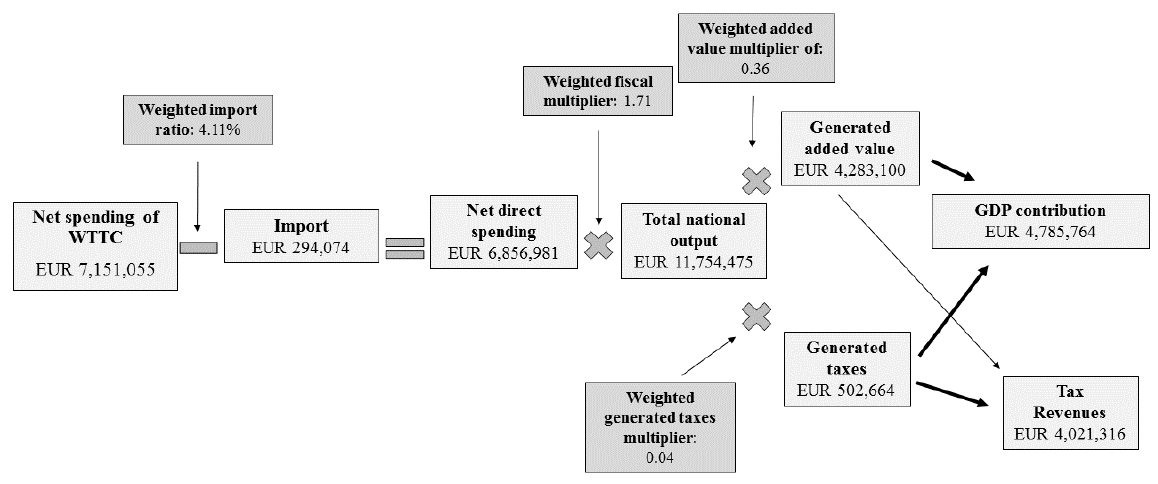
Figure 5. Economic impact of Liebherr 2019 WTTC